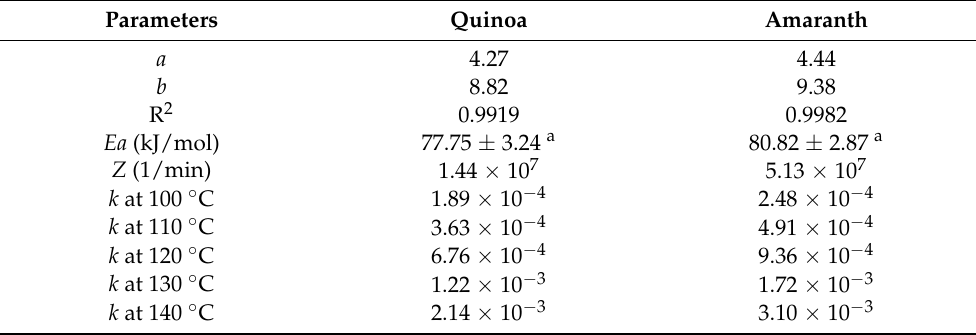
Table 4. Kinetics parameters ( a and b —adjustable coefficients, Ea —activation energy, Z —pre- exponential factor, k —reaction rate coefficient) of oxidation of oils extracted from quinoa and ama- ranth seeds.